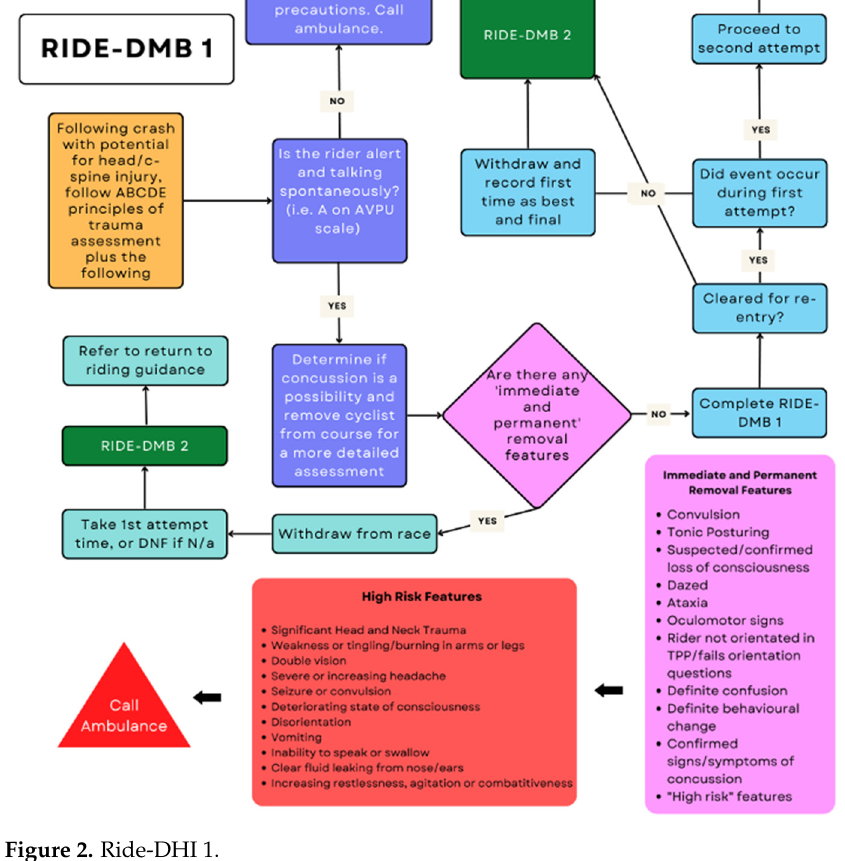
Figure 2. Ride-DHI 1.